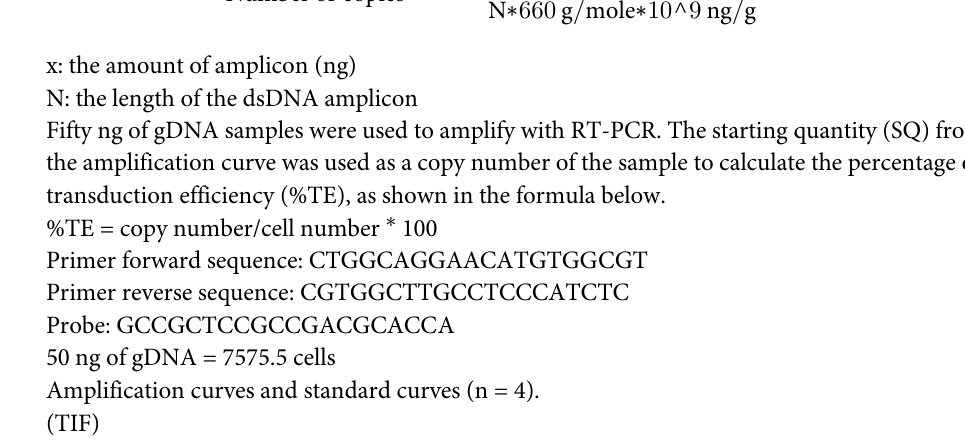
S3 Fig. The representative candidate of non-specific binding scFv. The intermolecular dock- ing displayed the interactions between the representative candidate of a non-specific binding scFv clone and membrane CD30 peptide (cyan), which mainly occurred at the framework regions (grey) of the scFv structure, not the CDR binding sites. This scFv molecule, as a result, had free CDR binding sites to bind to other molecules, resulting in non-specific binding. S4 Fig. The calculation of transduction efficiency (%TE) by RT-PCR. The standard curve was performed using 50 ng of gDNA, which was referred to as cell number 7575.5 cells, plus various amounts of amplicon in each copy number starting from 10 3 to 10 9 copies. By which the amount of amplicon in each copy number was calculated from the formula below. x ng ∗ 6 : 0221 ∗ 10 ^ 23 molecules = mole Number of copies ¼